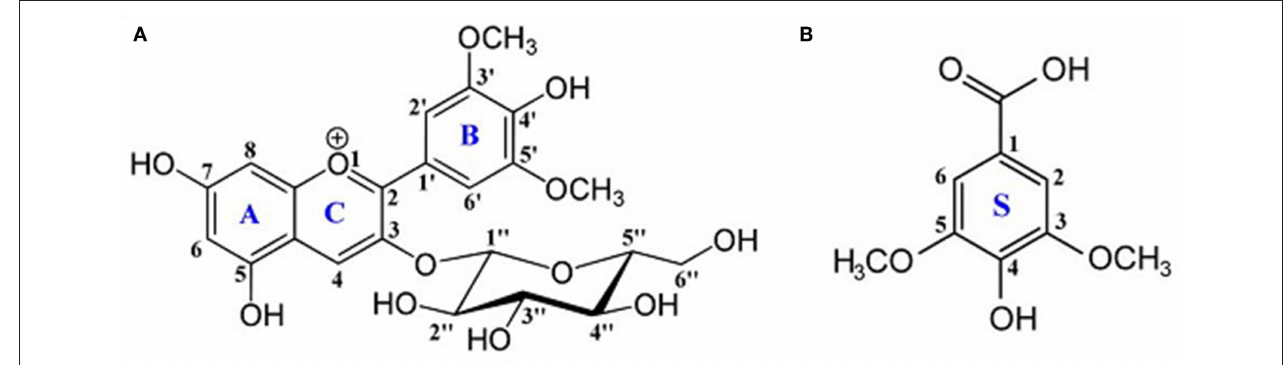
FIGURE 1 | Chemical structures of (A) oenin and (B) syringic acid. Backbone atoms and rings are